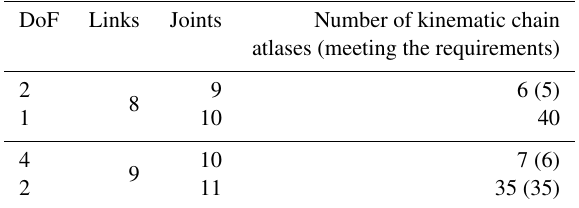
Figure 6. Generalization chain of existing design of the three- wheeler tilting motorcycle mechanism. Table 1. Number of available